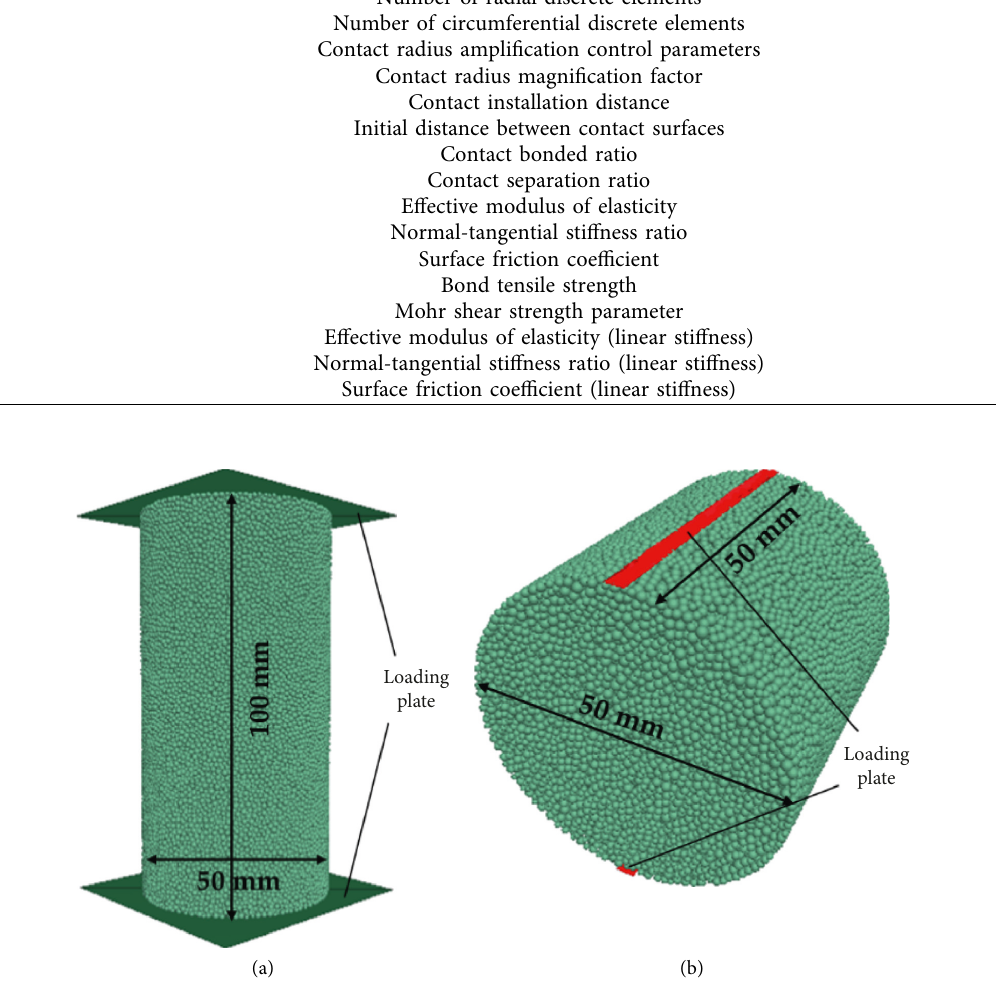
Figure 5: Numerical model: (a) unconfined compression test and (b) splitting test.